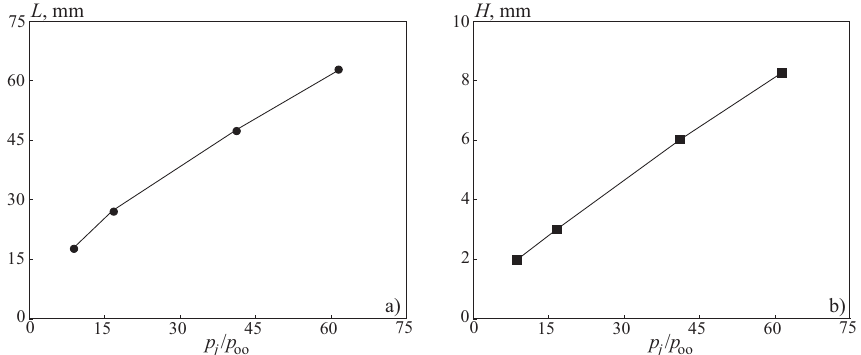
Figure 17. Length of the recirculation region ( a ) and the depth of jet penetration into the main flow ( b